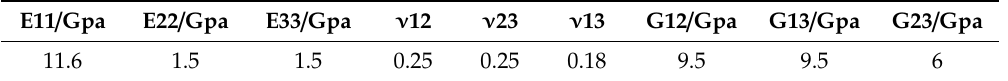
Table 1. Mechanical properties of the 3D tubular woven composites.